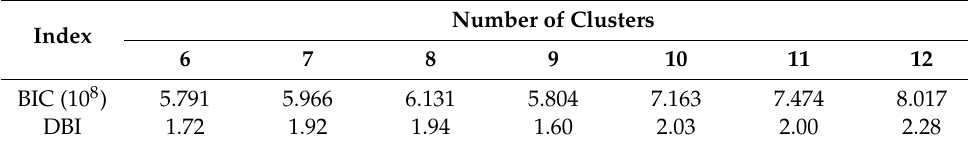
Table 4. Performance of various validity indices in different cluster numbers.